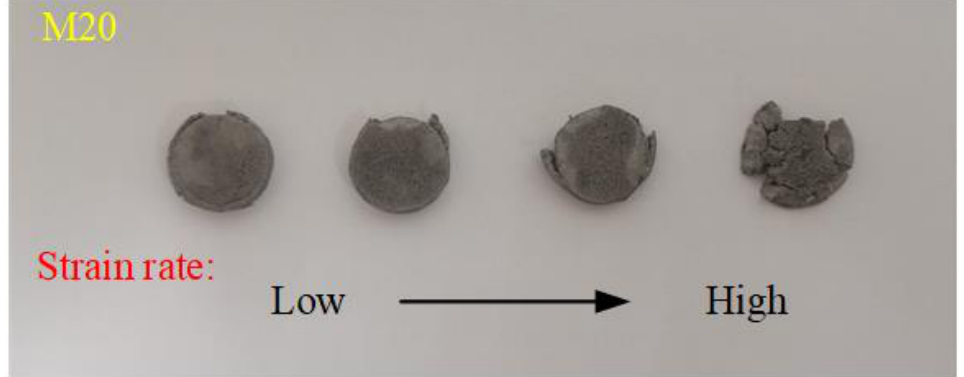
Figure 12. True stress–strain curves of Al-PTFE-W materials at elevated temperatures. ( a ) M20, ( b ) M50 and ( c ) M80.